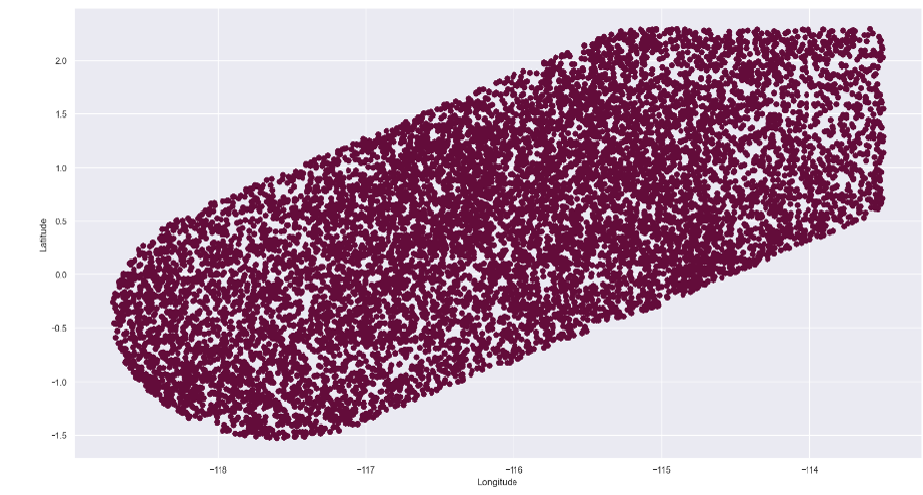
Figure 9. Location of User Equipment based on their latitude and longitude.